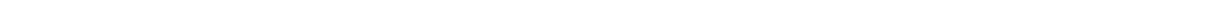
Fig. 3 hM4Di/CREB inhibition of cortical neurons after stroke blocks motor recovery. a Schematic shows the process by which DREADD hM4Di-CREB when activated by CNO (30 min before behavioral tasks) can lead to selective inactivation of neurons in motor cortex in which CREB is induced. b Immunohistochemical staining in peri-infarct M1 in mice transfected with hM4Di-CREB/eGFP (green, infected cells) overlapping with NeuN staining (purple) 4 weeks after stroke. Scale bar = 50 μ m. Stereological quanti fi cation of motor cortex M1 CREB-induced cells (CREB-eGFP + cells) relative to the whole motor cortex (NeuN + cells). c Stereological quanti fi cation of two immediate early genes, pCREB (phospho-CREB) and Zif268, in hM4Di/CREB- induced neurons in M1 after CNO or Saline administration during pasta handling motor task. ** P < 0.05,*** P < 0.005, one way ANOVA followed by Bonferroni post hoc test n = 4. Eight brain sections for each mouse. d , f Gridwalking tasks of forelimb function in gait. Y axis is percentage of the number of footfaults of the right (affected) forelimb contralateral to the stroke. e , g Pasta handling tasks. Y axis is the percentage of left forelimb adjustments (unaffected forepaw) relative to right forepaw (stroke-affected forepaw). d , e CREB gain of function. In the absence of CNO, Stroke + hM4Di-CREB induction in peri-infarct M1 produces a signi fi cant recovery in forelimb function over 3 – 4 weeks after stroke, respectively in pasta handling adjustments and gridwalking, as with studies in Fig. 2b, d. n = 13 for stroke CREB CNO, n = 10 for CREB, and n = 9 for stroke CREB. f , g Selective inactivation with